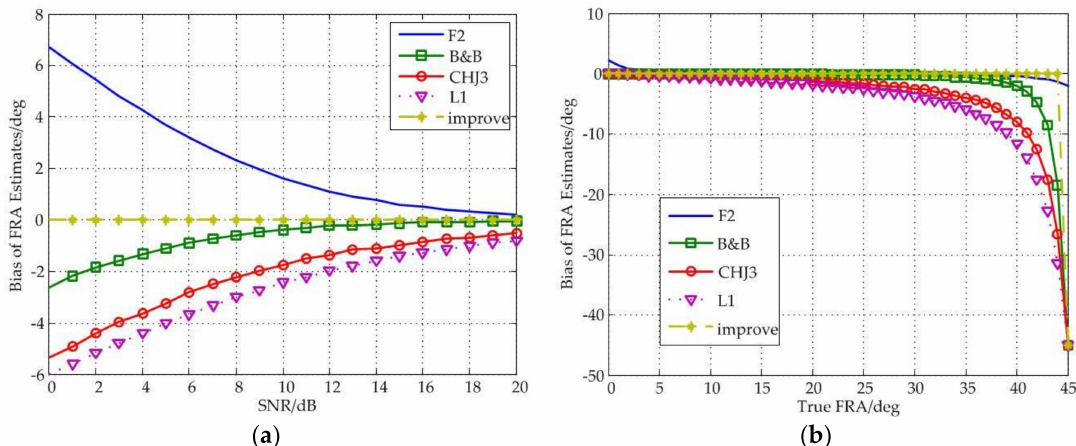
Figure 2. ( a ) Bias of FRA estimates as a function of SNR under different estimators; ( b ) Bias of FRA estimates as a function of true FRA under different estimators.